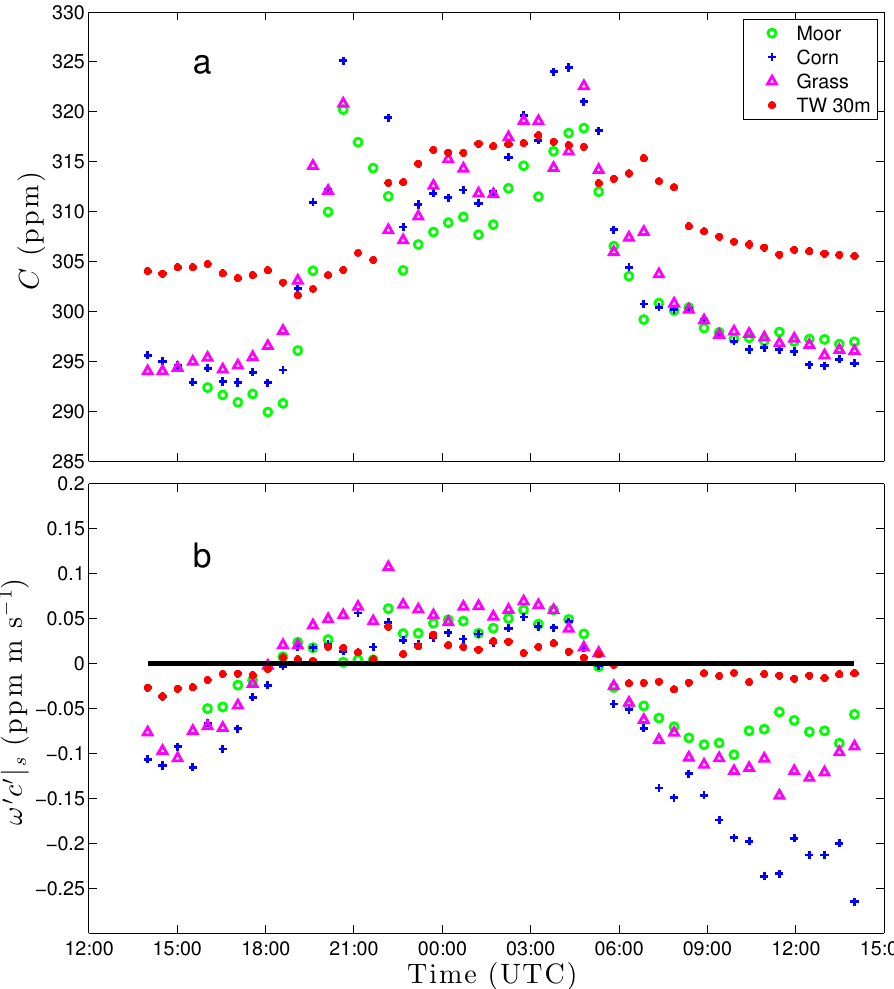
Fig. 9. Temporal evolution from 30 June 2011 at 14:00UTC to 1 July 2011 at 14:00UTC of the observed (a) CO 2 mixing ratio and (b) CO 2 surface flux measured at 2m over moor (green circles), over corn (blue crosses), over long grass (magenta triangles) and at 30m over grass (red asterisks).